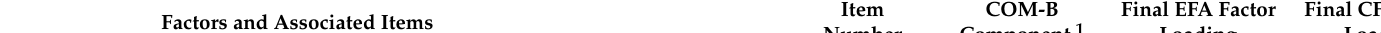
Factors and Associated Items